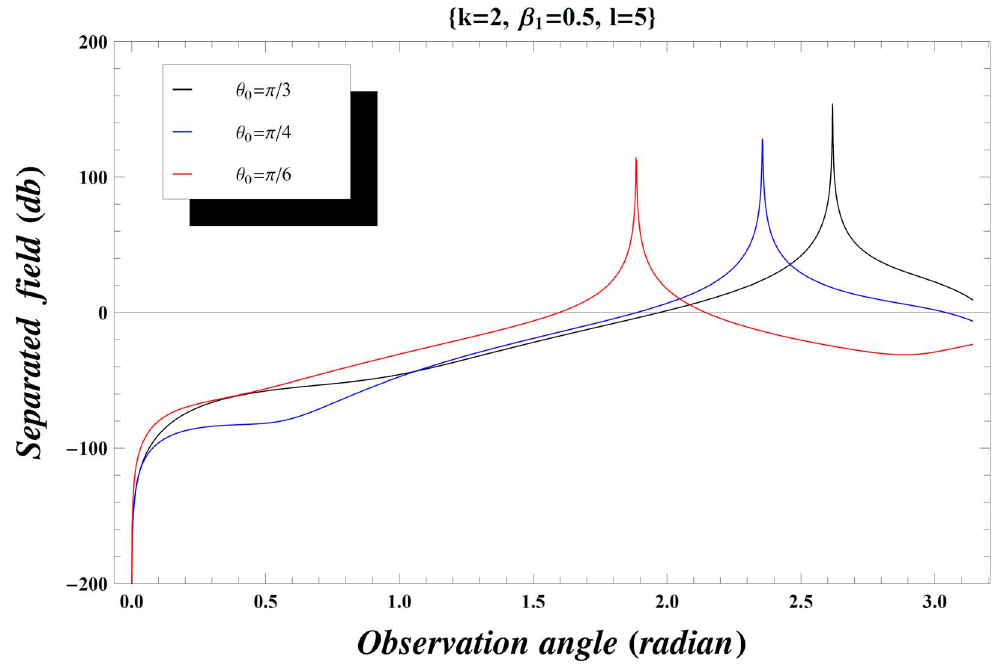
Figure 3. Separated field versus observation angle for different values of incidence angle h 0 when k ~ 2 .